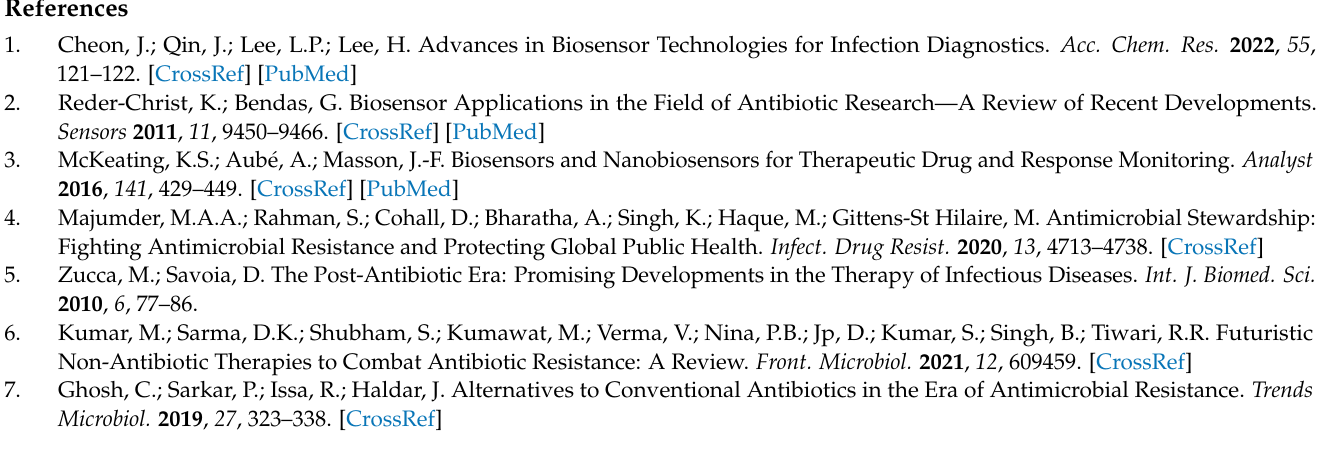
Figure S2: Time-resolved conductance (G m ) and capacitance (C m ) shifts and Bode plots for negative control experiment; Figure S3: Time-resolved conductance (G m ) and capacitance (C m ) shifts and Bode plots upon 63 µ M, 31 µ M, and 16 µ M GML addition to the tBLM platform; Figure S4: Time-resolved conductance (G m ) and capacitance (C m ) shifts and Bode plots upon 250 µ M LA addition to the tBLM